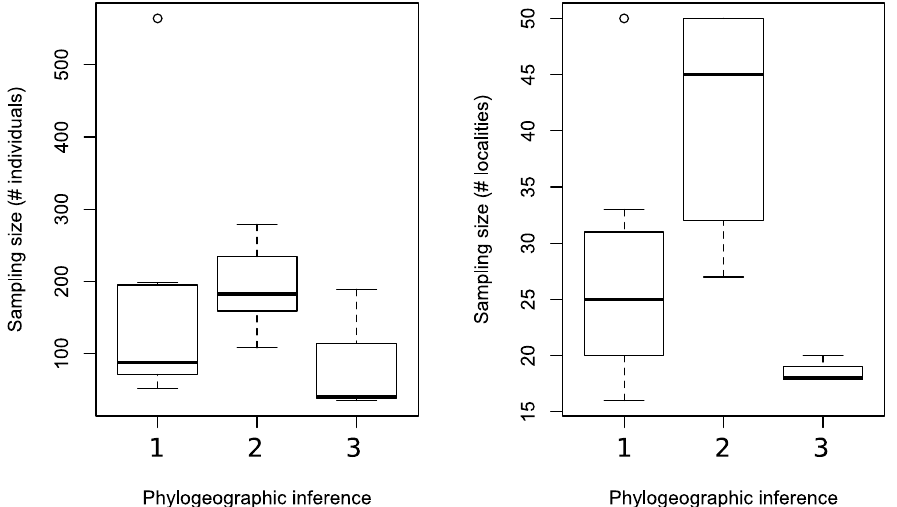
Figure 6. The fixation indices ( Φ ST) calculated between western and eastern populations. The red dashed line indicates the original estimated value (86 individuals from western and 100 individu- als from eastern populations).